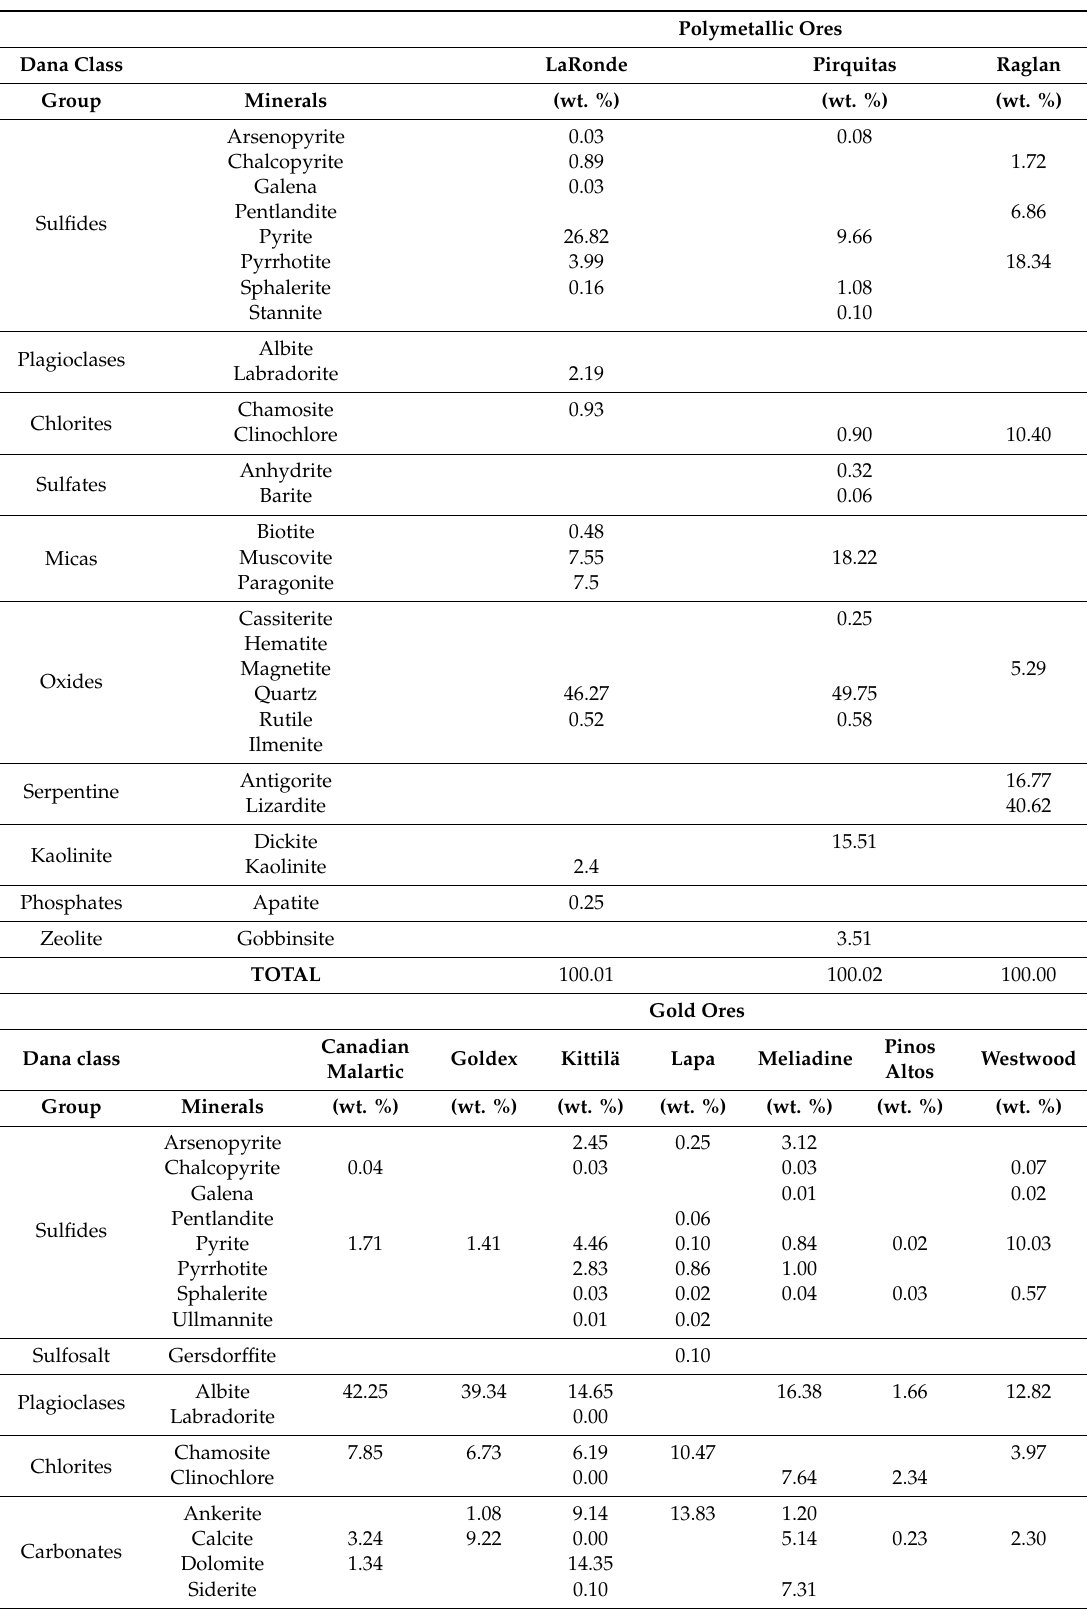
Table 3. Quantitative mineralogical composition determined by chemical / mineralogical